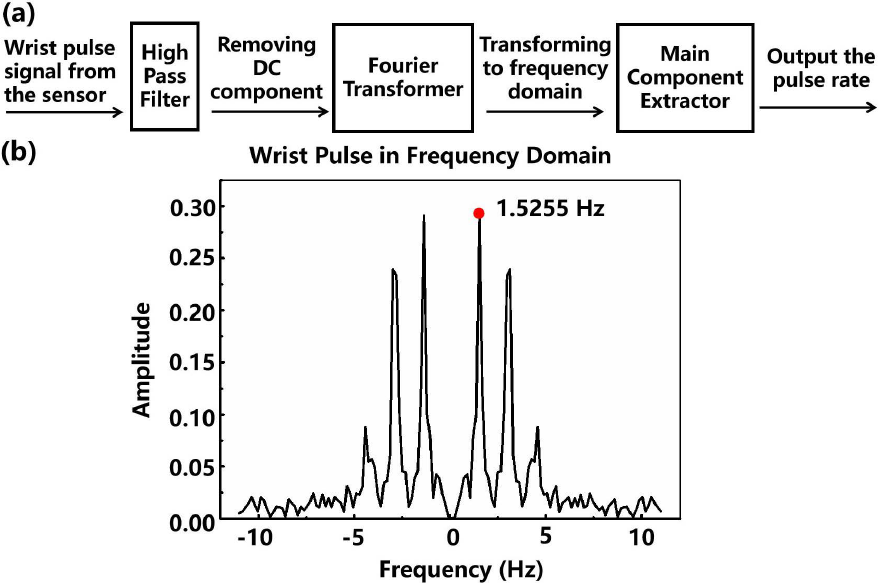
Figure 6. ( a ) The diagram of extracting the pulse rate from the sensor attached to the skin of the subject’s wrist. ( b ) The Fourier-transformed wrist pulse